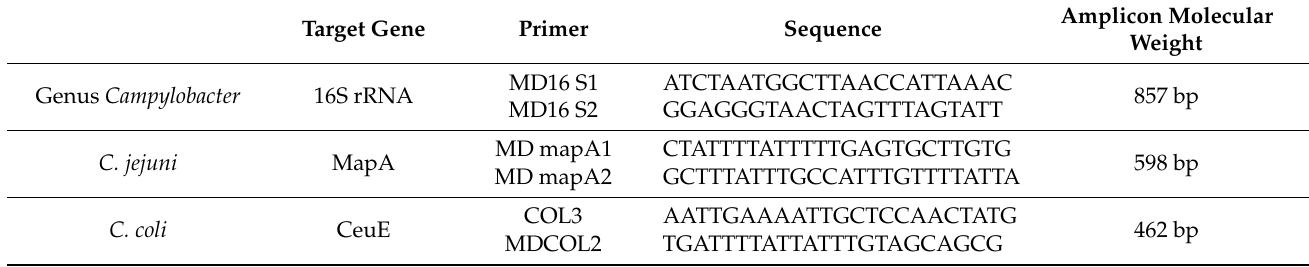
Table 2. Primers used for the identification of C. jejuni and C. coli .